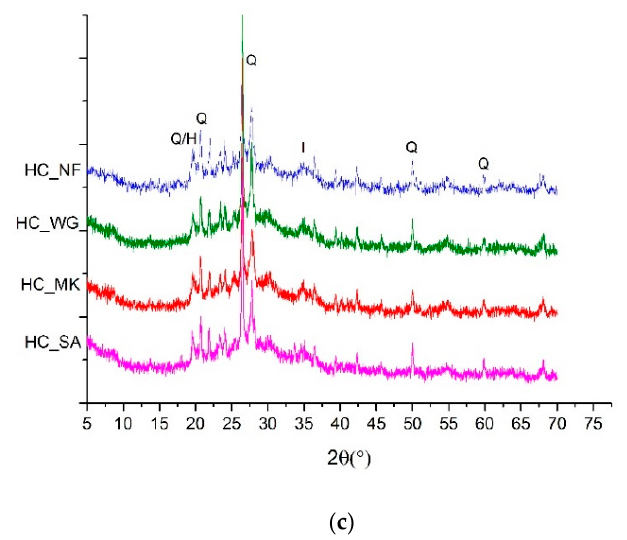
Figure 6. Comparison of X-ray diffraction spectra of clays and samples made with them: ( a ) samples with SC clay; ( b ) samples with KC clay; ( c ) samples with HC clay. (Q = quartz; I = illite; K= kaolinite; H = halloysite) .